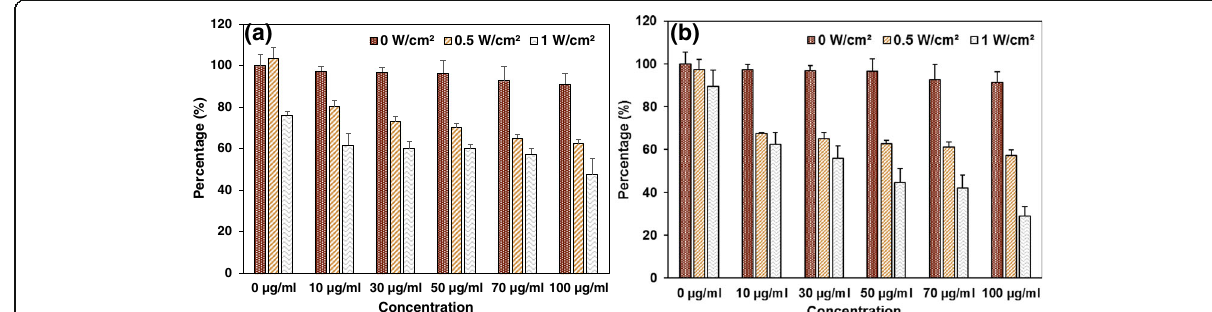
Fig. 8 Percentage of cells alive from the cells treated with FePt@PPy NPs under different laser power densities and different irradiation time. a Irradiation was performed for 4 min. b Irradiation was performed for 6 min